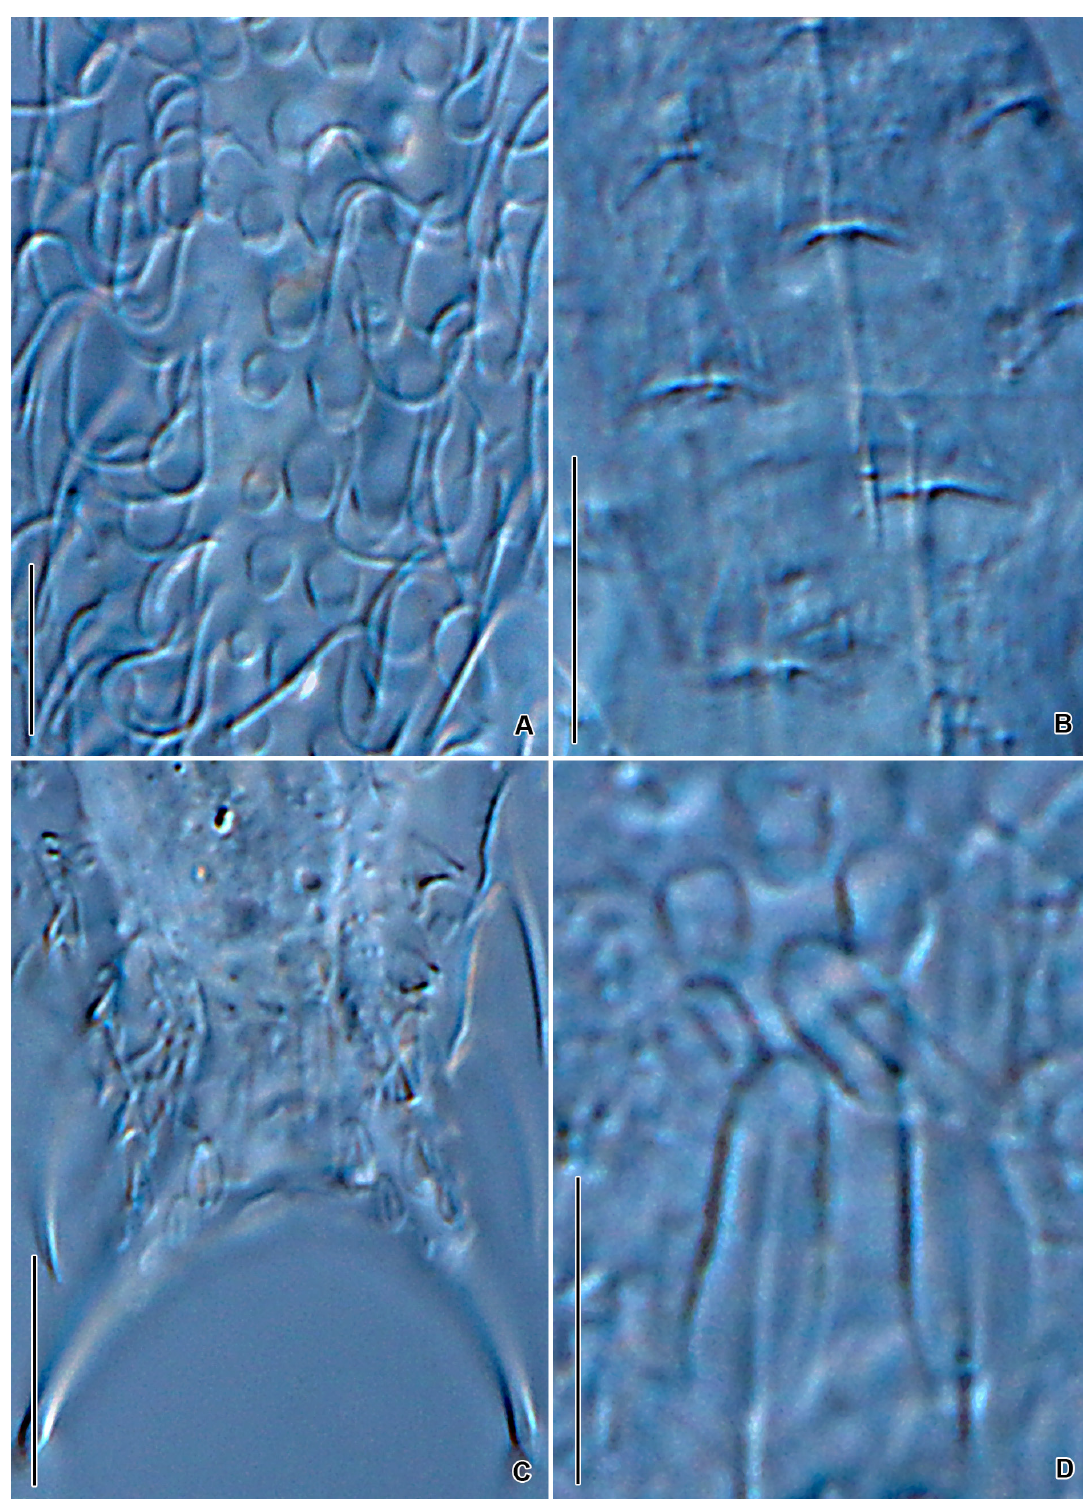
Fig. 36. Chaetonotus ( Hystricochaetonotus ) gulosus sp. nov., paratype (CU-FNS-28-10-19/PA), differential interference contrast. A . Scales of the ventral interciliary field. B . Dorsal trunk scales. C . Detail of the posterior body region. D . Posterior ventral keeled and spined scales. Scale bars: A, D = 5 µm; B–C = 10